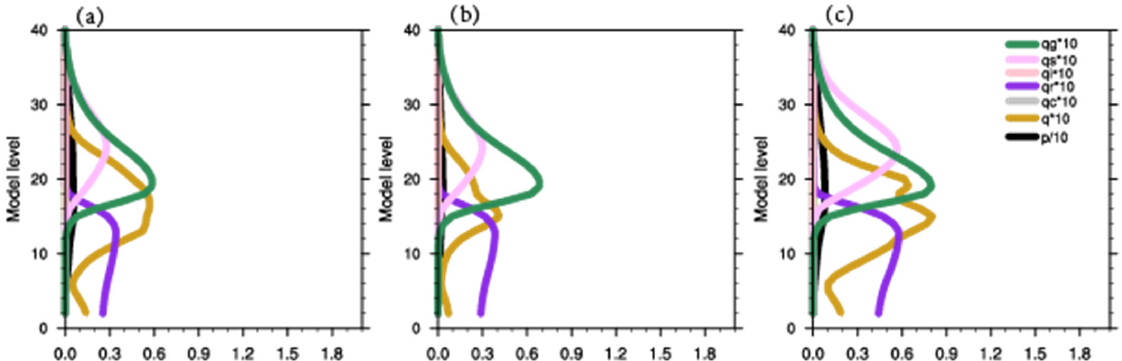
Figure 9. RMS profiles of the analysis increment for each variable at ( a ) 0000 UTC, 13 September ( b ) 0300 UTC, 13 September ( c ) 0600 UTC, 13 September (U, V in m/s, t in K, and other hydrometeors in 10 g/kg) for experiment DA_Radar_CVH.